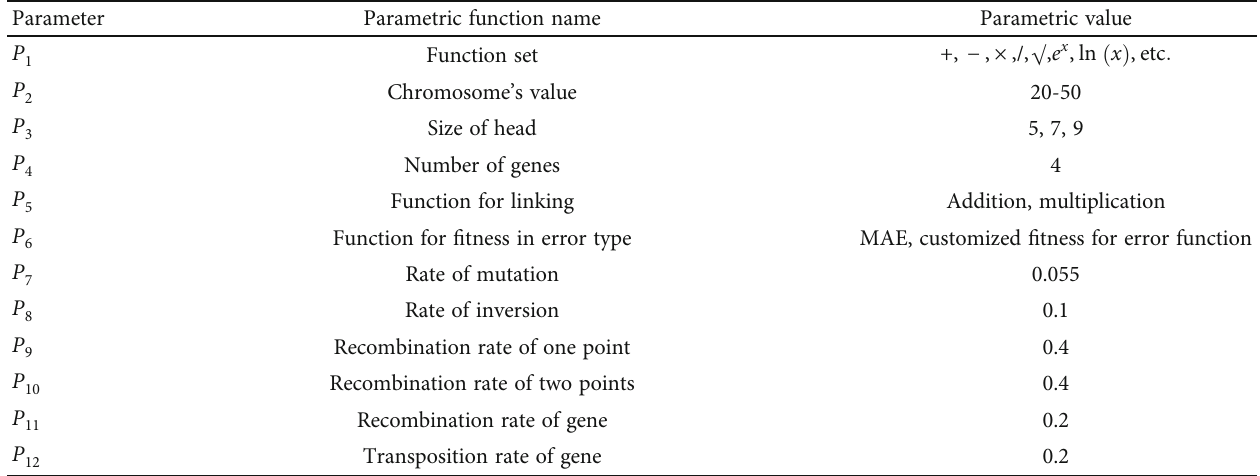
Table 2: The parameters which are used in GEP model.